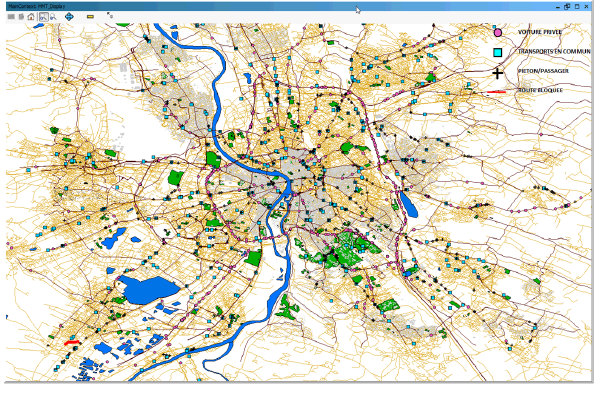
Figure 3. Interface of